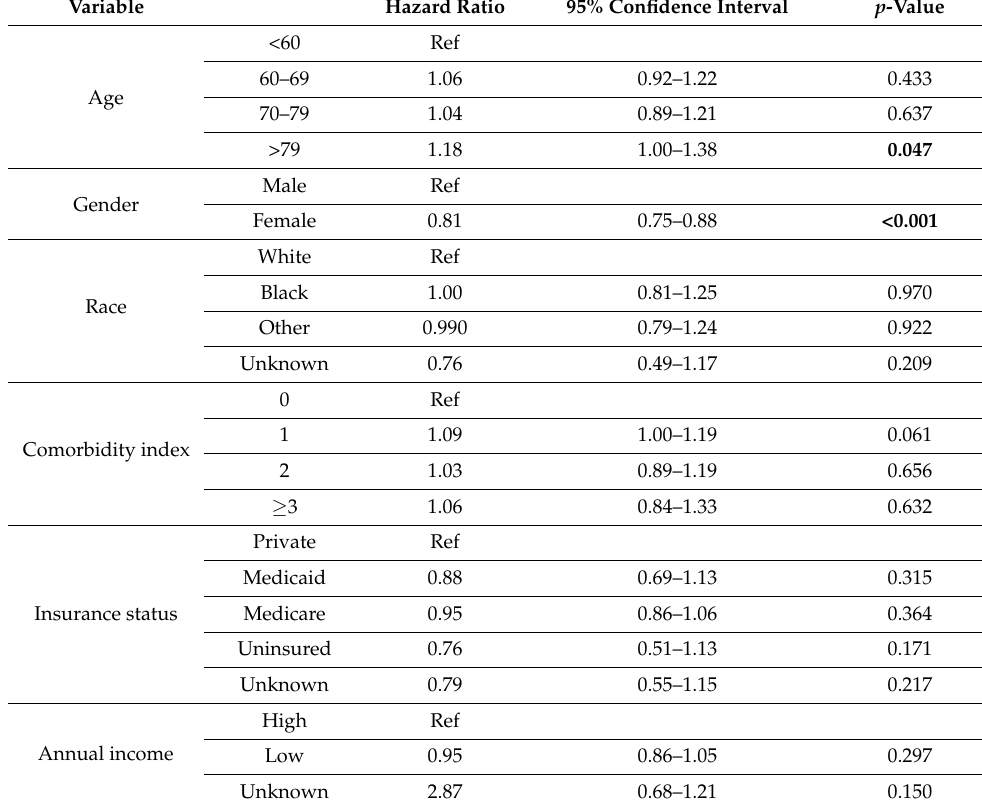
Table 2. Multivariable logistic regression analysis examining factors associated with undergoing segmental ureterectomy compared to radical